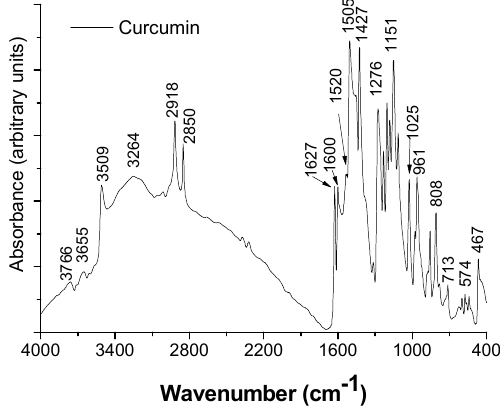
Figure 6. ATR-FTIR spectrum of the neat curcumin (CR) utilized in this study.